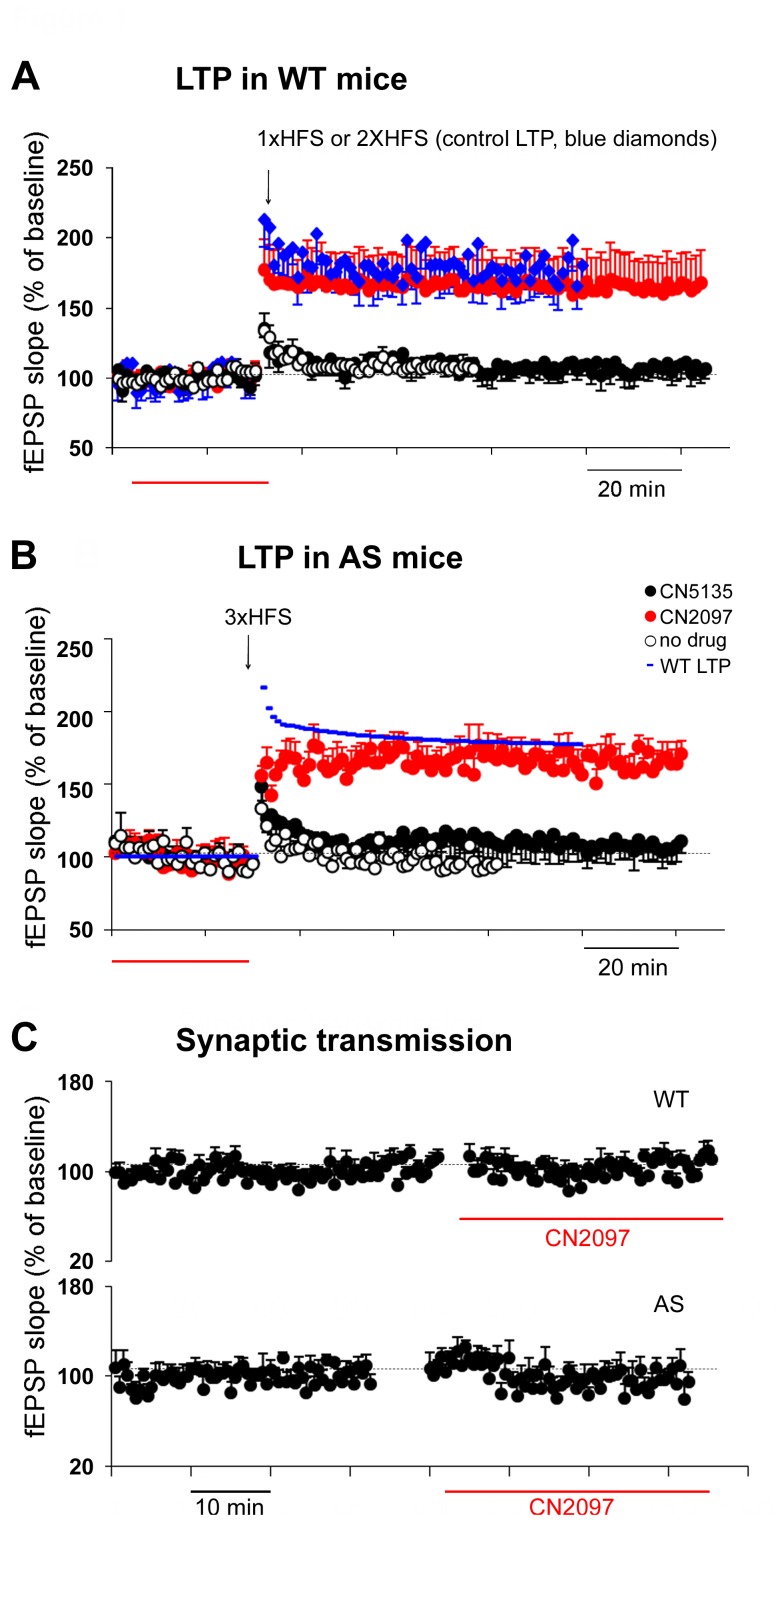
Defective BDNF-mediated synaptic plasticity in AS mice is mitigated by CN2097.Field EPSP slopes plotted as a percentage of pre-tetanus baseline in the CA1 region of the hippocampus. (A) LTP in WT mice. A single HFS train (1× HFS; 1-s train at 100 Hz) was insufficient to induce LTP (open circles), whereas 2-× 1-s trains at 100 Hz separated by 15-s resulted in LTP (blue diamonds; 2× HFS). Following application of 2 µM CN2097 for 30 min, a 1× HFS stimulus now produced significant LTP (red dots, CN2097) comparable to the 2× HFS protocol (blue diamonds). A single HFS in the presence of the negative control CN5135 had no effect on LTP (black dots, CN5135). Red bar, time of drug application. (B) LTP in AS mice. Three HFS trains 10 s apart (3× HFS) had no significant effect on fEPSP slopes (open circles, no drug). Following application of 2 µM CN2097 for 30 min, the 3× HFS stimulation protocol resulted in LTP (red dots, CN2097). No such effect was observed when the slices were incubated with the control peptide CN5135 (black dots). For comparison, WT LTP induced using the 2× HFS is shown (blue line, same data as in [A]; fitted using IGOR Pro program). Red bar, time of drug application. (C) CN2097 (2 µM, red bar) had no significant effect on baseline synaptic transmission either in WT (top) or AS mice (bottom).